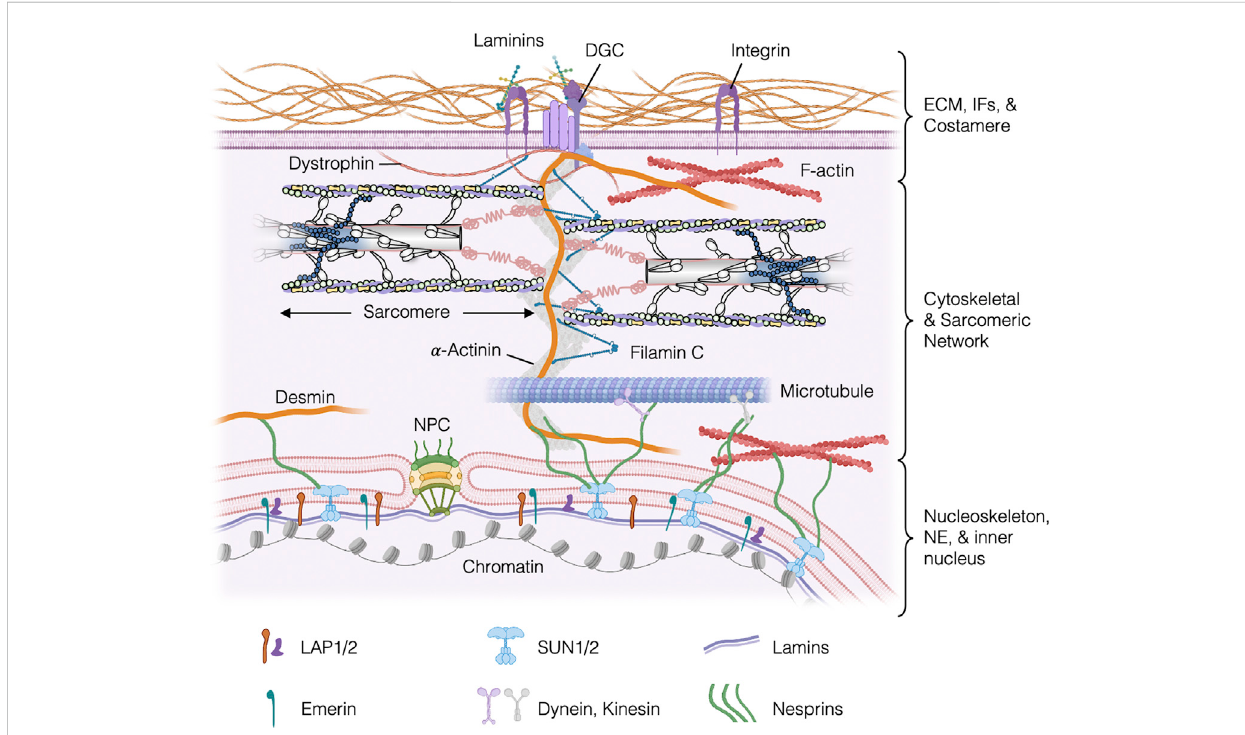
FIGURE 1 Schematic of the intracellular environment of a mature cardiomyocyte, illustrating mechanical coupling between the ECM the costamere, the sarcomere, the nucleoskeleton, and chromatin. Costameres consists of integrins, laminins, and DGCs (among other proteins not depicted here) and provides linkages between the Z-disks of the sarcomere, IFs in the cortical cytoskeleton, and the ECM, and other cytoskeletal IFs. Desmin, a-actinin, and Filamin C provide (among other proteins not shown here for clarity) provide structural integrity to the Z-disk, to which myo fi laments of the sarcomere are anchored. ECM, extracellular matrix; IFs, intermediate fi laments; DGC, dystrophin-glycoprotein complex; LAP1/2, lamina-associated polypeptide 1/2; NPC, nuclear pore complex; NE, nuclear